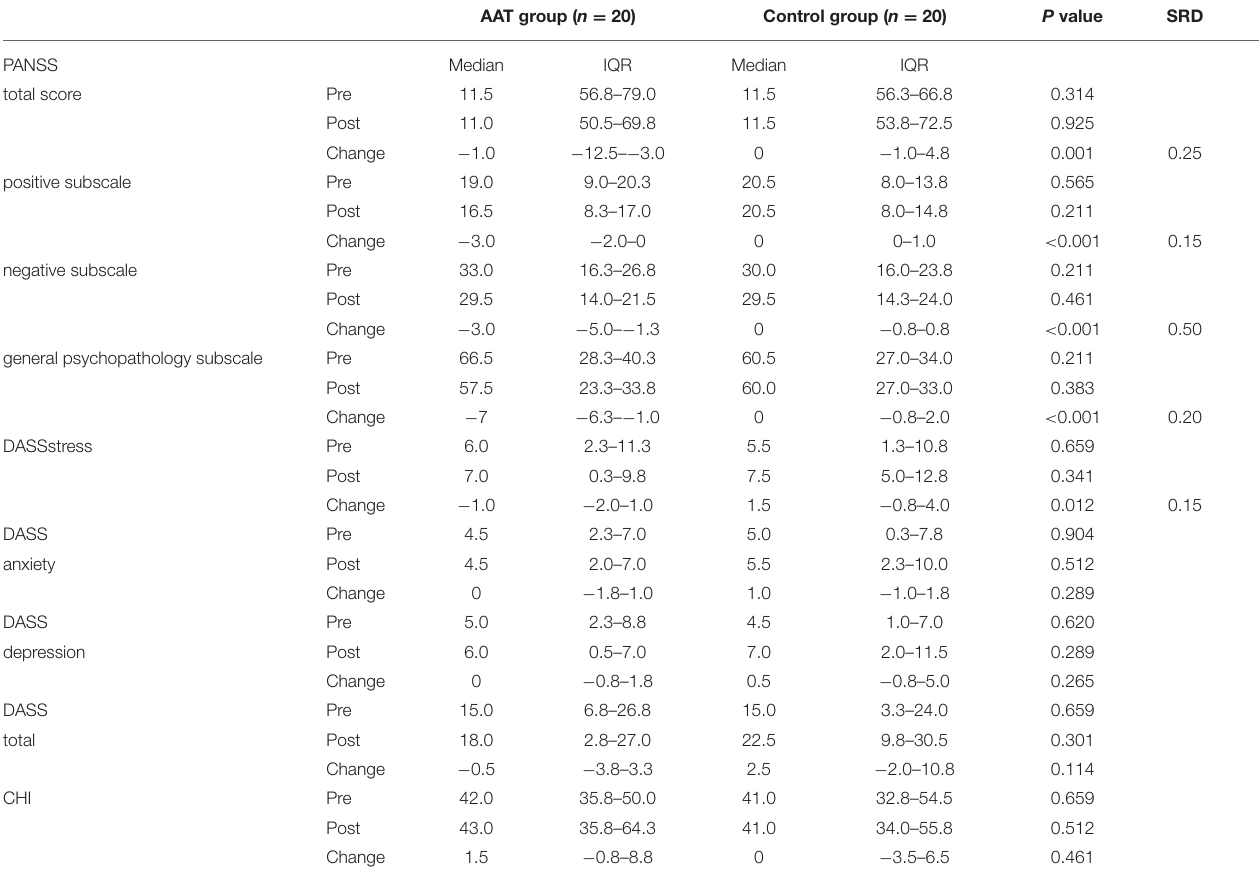
TABLE 2 | Median and interquartile range of PANSS, DASS, and CHI change scores between pre-test and post-test for the AAT group and control group.